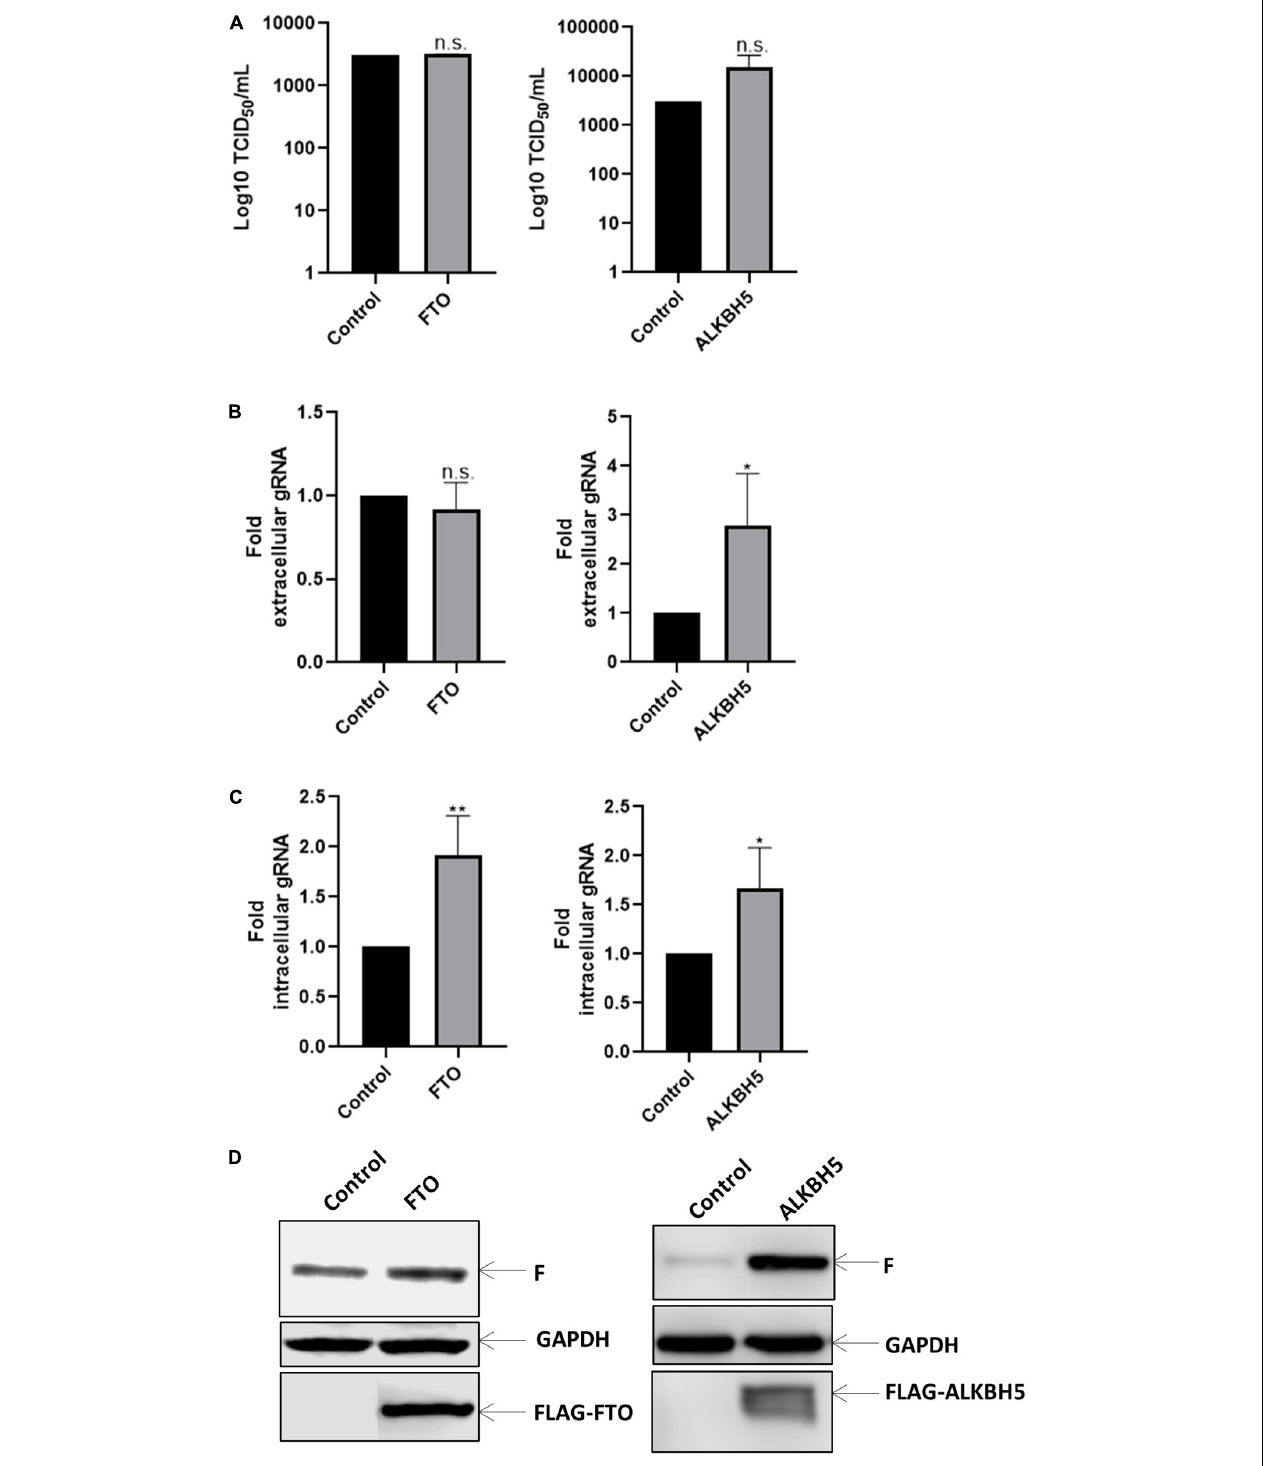
FIGURE 2 | Erasers proteins favor gRNA synthesis. HEK293T cells were transfected with the vector expressing Flag-tagged FTO or ALKBH5 a control vector expressing d2EGFP. Then the cells were infected with HRSV at MOI:1 for 24 h. (A) The supernatant was recovered, and the infectious titer was analyzed by the TCID 50 assay. (B) The extracellular and (C) intracellular gRNA was quantified by RT-qPCR. Results were normalized vs. the control (arbitrary set to 1) and expressed as the mean ± SD of three independent experiments. (D) Cell lysates from infected cells were used for the detection of the F protein and Flag-tagged proteins by Western blot. GAPDH was used as a loading control (* p < 0.05; ** p < 0.01; ns, not significant).